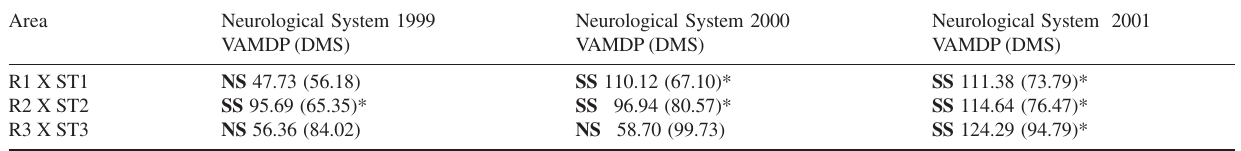
Table 7 – Comparative analysis of average correct answers in neurological imaging in 1999-2001 (*P< 0.001)